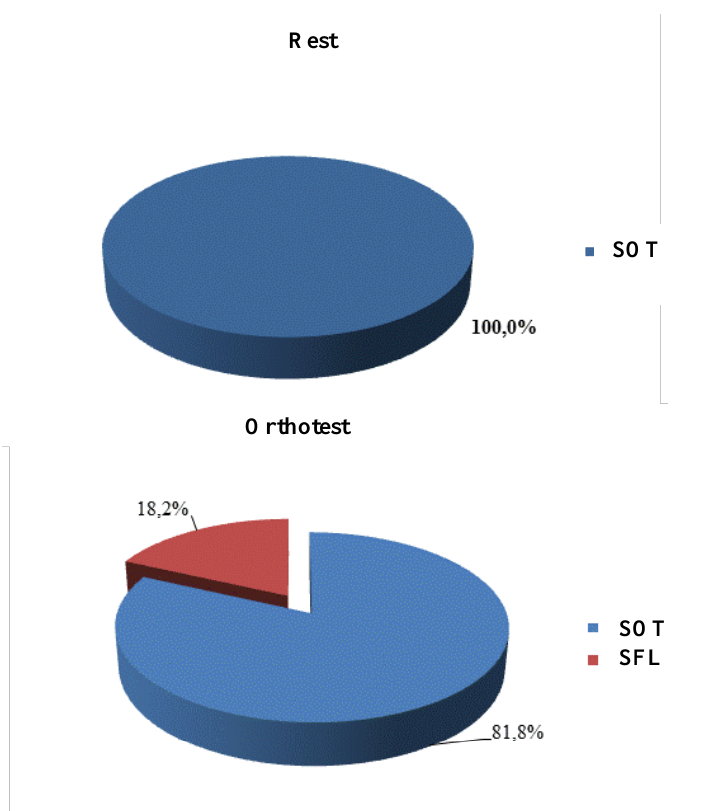
Fig.2. Distribution of states of optimal (SOT - Sm, SmSb, SmSbSf, Sb, SbSm, SbSmSf), functional tension (SFT - SmSfSb, SbSfSm) of regulatory mechanisms in rest and after AFL of sportsmen without CT